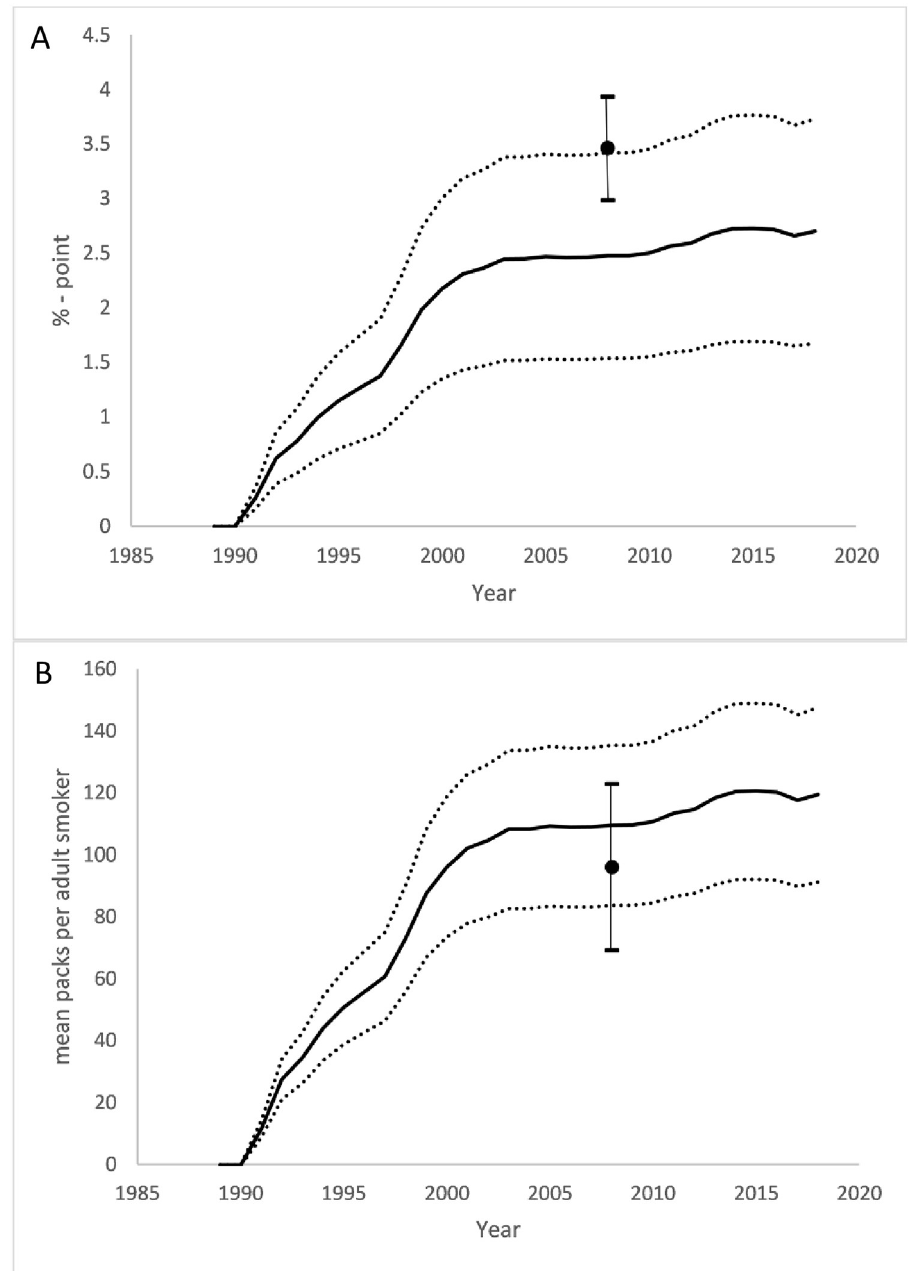
Fig 1. Reductions in smoking attributable to the CTCP. (A) Adult smoking prevalence. (B) Mean packs per current smoker. Black line: mean; Dotted lines: lower and upper 95% confidence intervals for prediction; Black dots and error bars: point and 95% confidence interval reported in the ECTCP [4] 2013